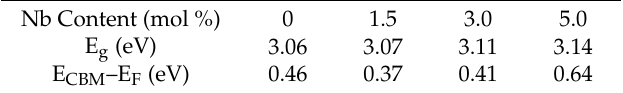
Table 1. Optical bandgap values for TiO 2 samples with different Nb contents.